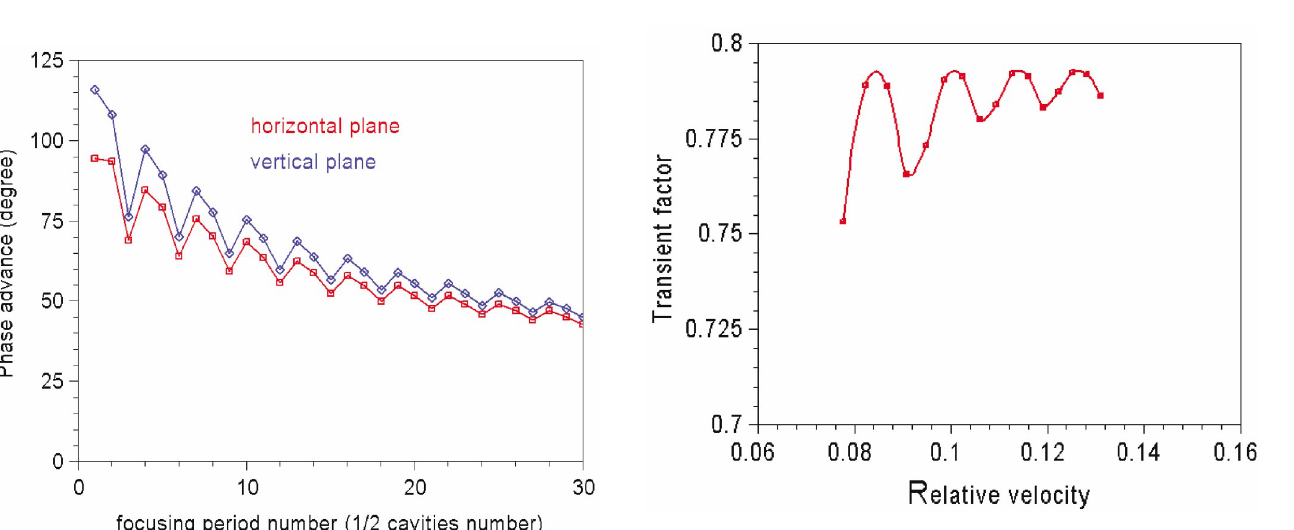
FIG. 13. (Color) Phase advance in both